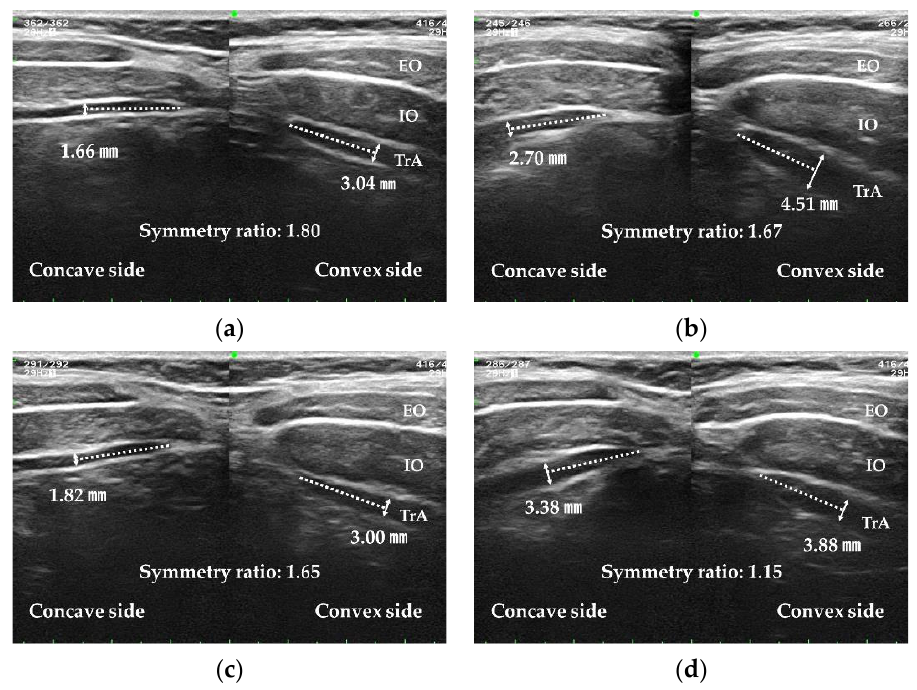
Figure 4. Results of an ultrasound imaging measurement. The symmetry ratio was calculated as the transversus abdominis thickness on the convex side of the lumbar curve divided by the thickness on the concave side. EO: external oblique; IO: internal oblique; TrA: transversus abdominis. ( a ) No correction and no contraction; ( b ) no correction and contraction; ( c ) correction and no contraction; and ( d ) correction and contraction.